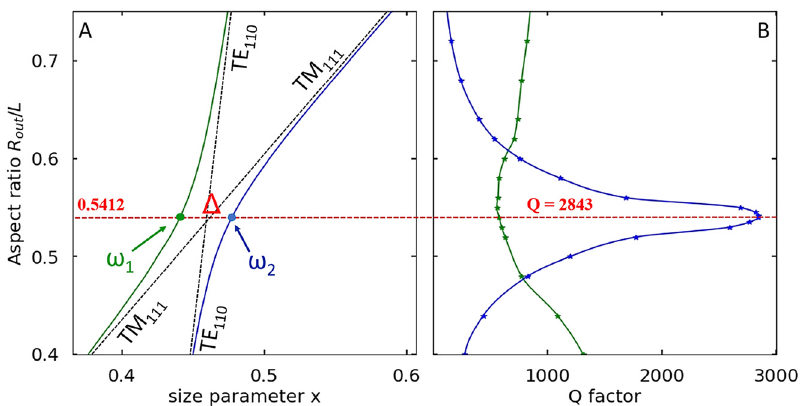
and TM branches. 1,1,0 1,1,1 (rapidly varying Fabry–Perot-type mode) in finite cylindrical dielectric resonator. The 1 , 1 , 1 ∕ L = 0 . 5412). (B) Q -factor evolution for the high-frequency branch (blue curve, quasi-BIC) and the out = 80, 𝜖 = 1. 1 2